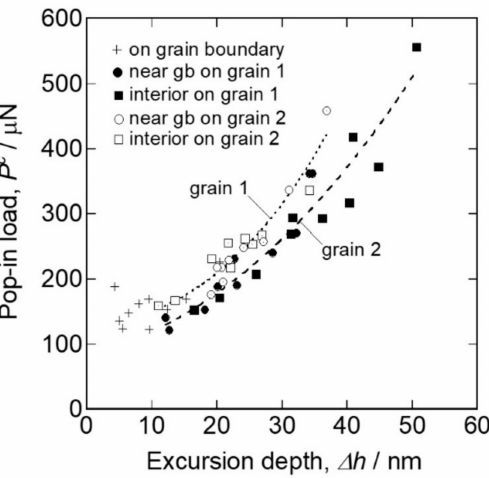
Figure 15. Relation between the critical load, P c , and pop-in depth, ∆ h